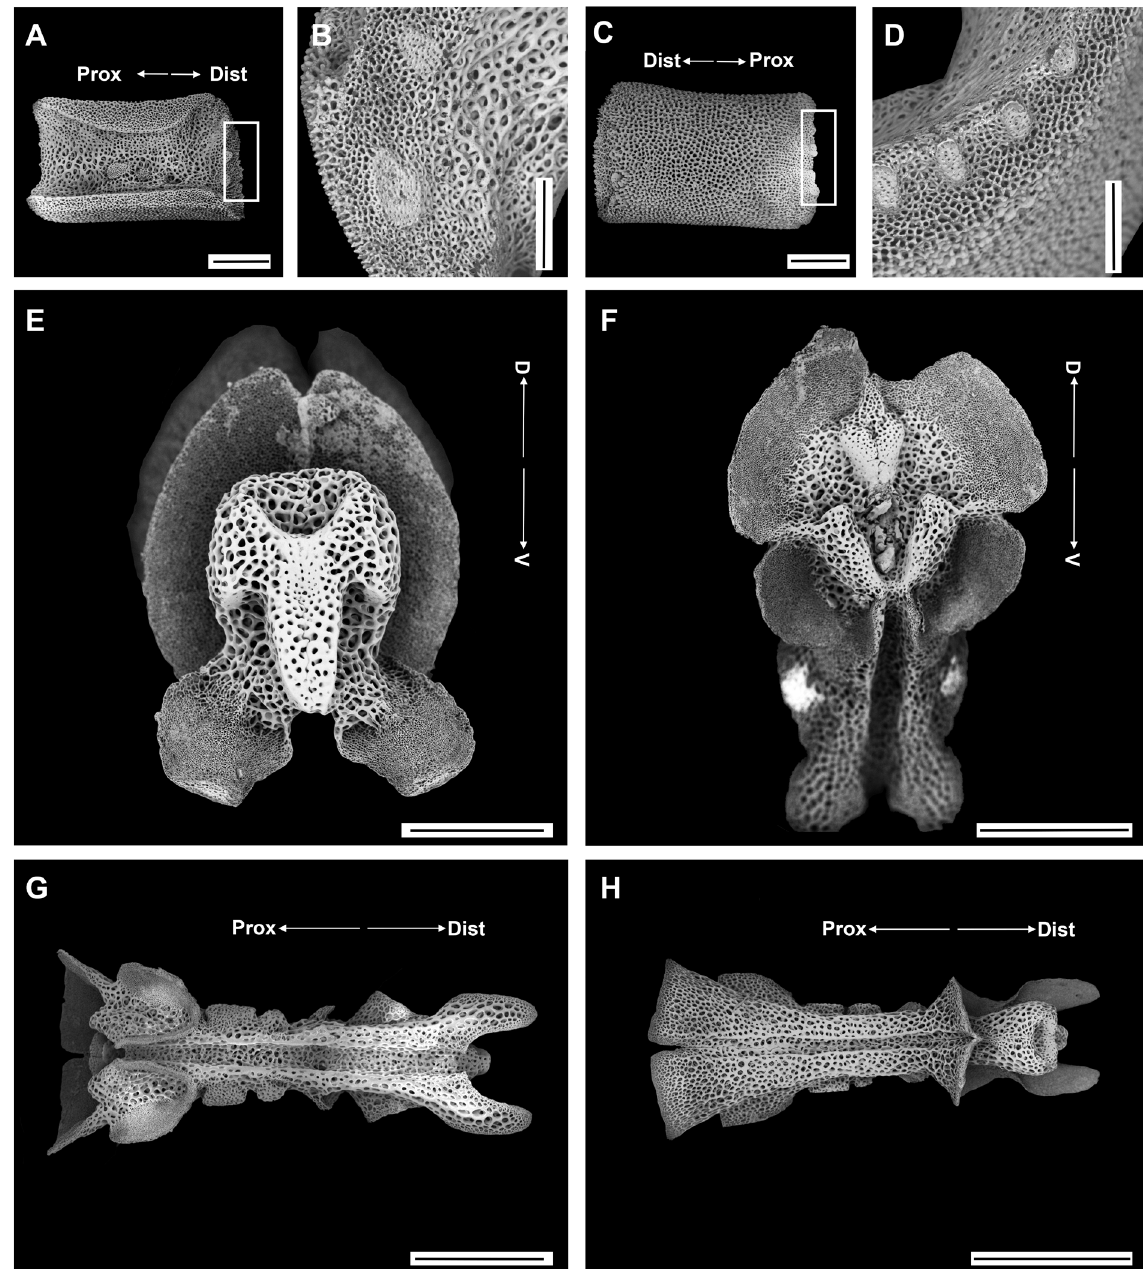
Fig. 14. Ophiomusa lymani (Wyville Thomson, 1873), SEM (IDSSE EEB-SW0008). A–B . Internal view of lateral arm plate. C–D . External view of lateral arm plate. E–H . Vertebrae. E . Distal view. F . Proximal view. G . Ventral view. H . Dorsal view. Abbreviations: D = dorsal; Dist = distal; Prox = proximal; V = ventral. Scale bars: A, C, E–G = 500 µm; B, D = 300 µm; H = 800